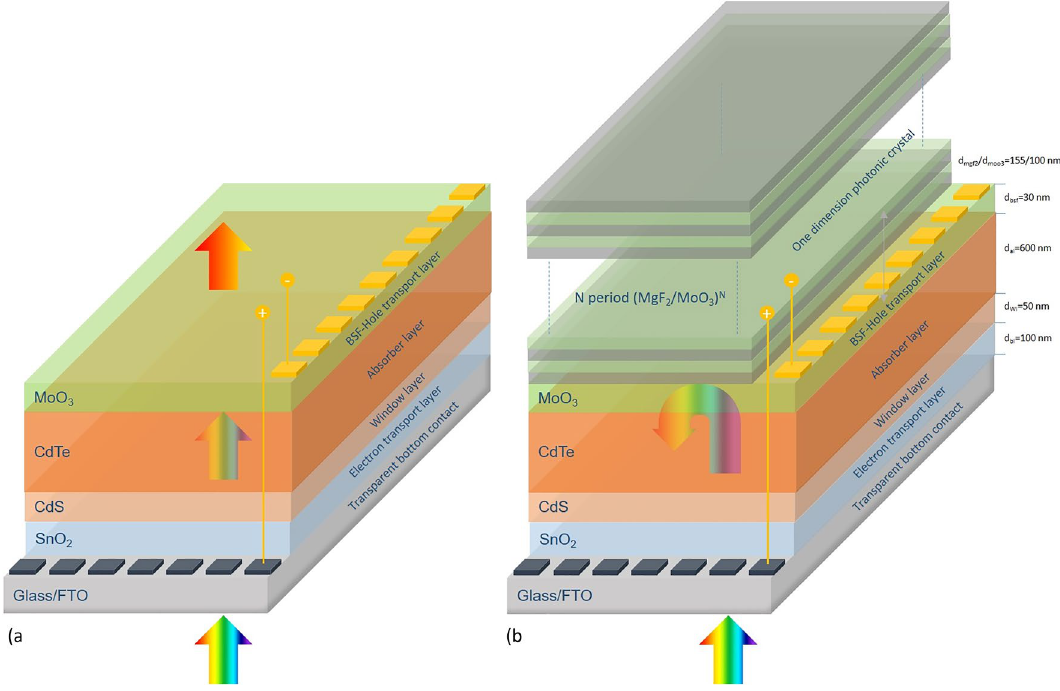
Figure 1. CdTe-based SCs: ( a ) FTO/SnO 2 /CdS/CdTe/MoO 3 and ( b ) FTO/SnO 2 /CdS/CdTe/MoO 3 /(MgF 2 /